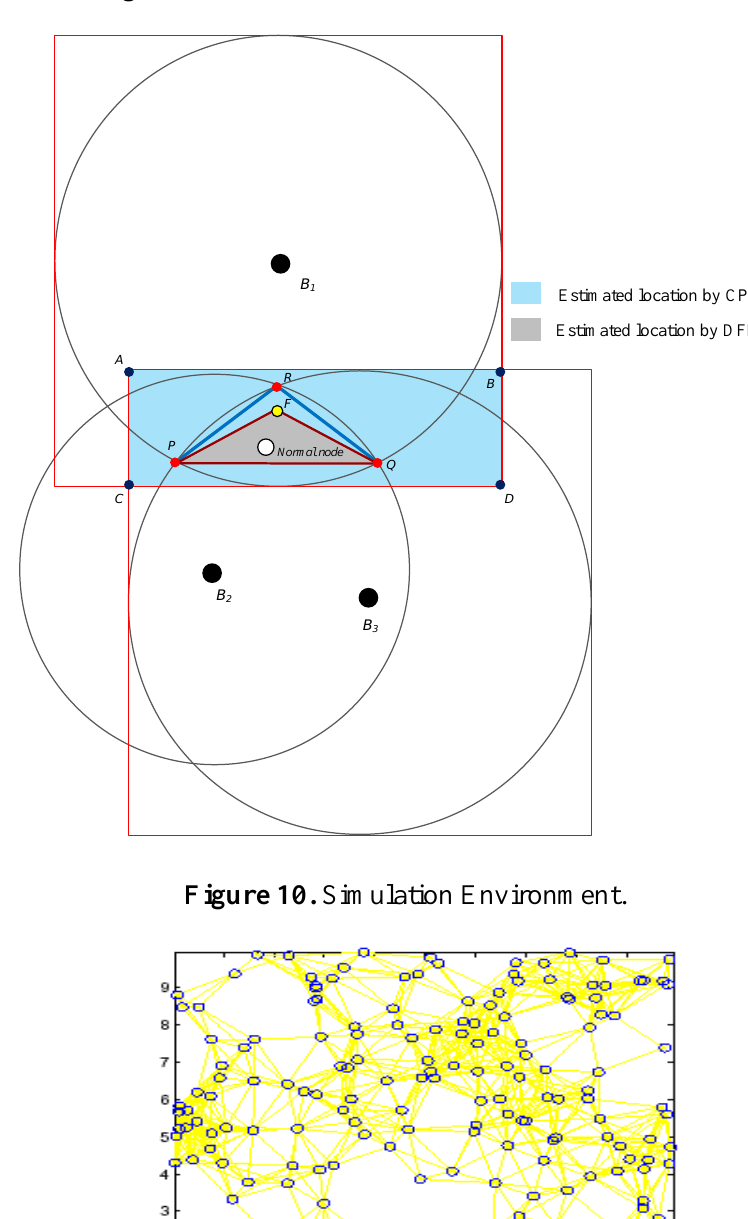
Figure 9. Location Estimation of DFPLE and CPE.